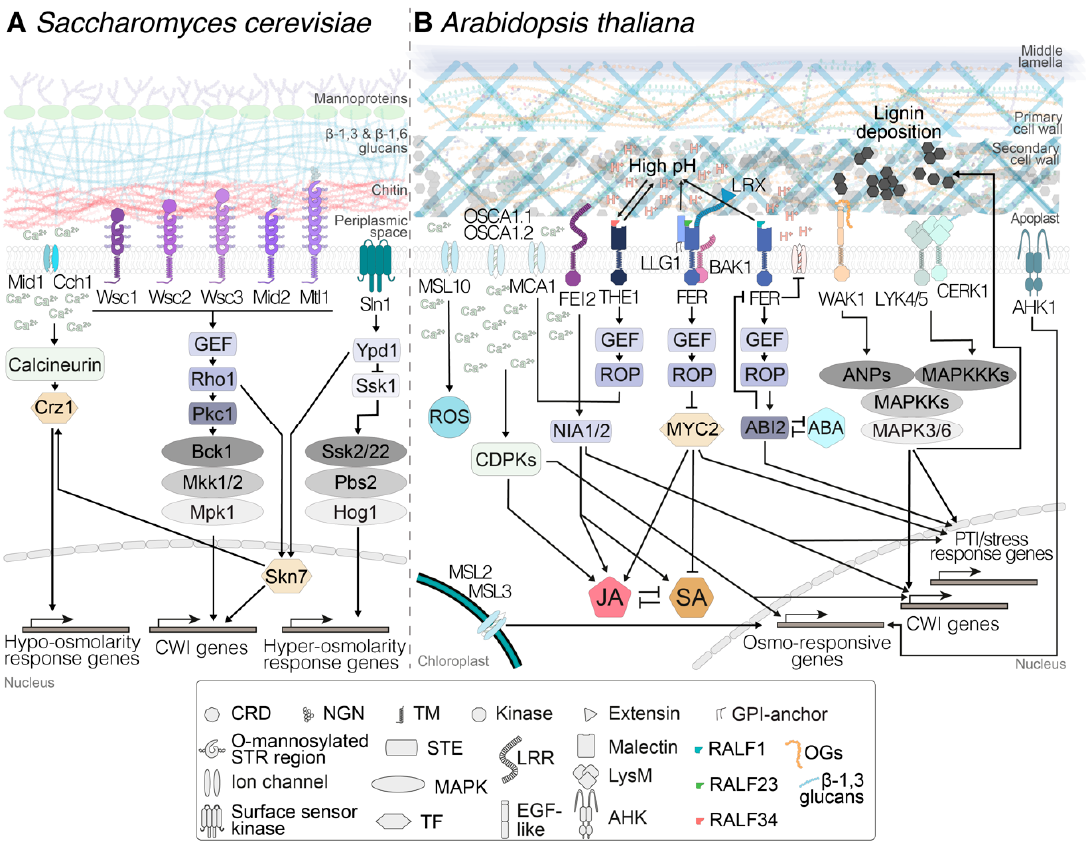
Figure 1. Comparison between cell wall integrity (CWI) maintenance mechanisms in ( A ) Saccharomyces cerevisiae and ( B ) Arabidopsis thaliana. In both organisms, mechanosensitive ion channels and receptors trigger signal transduction processes involving Ca 2+ influx into the cytoplasm and the activation of cascades including calcium-dependent protein kinases (CDPKs), guanosine nucleotide exchange factors (GEFs) and mitogen-activated protein kinases (MAPKs) that eventually activate transcription factors. In A. thaliana , the processes are regulated in a more intricate manner, exemplified by the complex interconnected networks regulated by jasmonic acid (JA), salicylic acid (SA), and abscisic acid (ABA). The processes enable the regulation of gene expression in a tightly controlled and highly adaptive manner, allowing specific changes in cell wall and cellular metabolism to maintain cell wall integrity. Arrows are connecting elements belonging to the same pathway. ROS: reactive oxygen species; PTI: PAMP-triggered immunity; CRD: cysteine-rich domain; NGN: N-glycosilated asparagine;